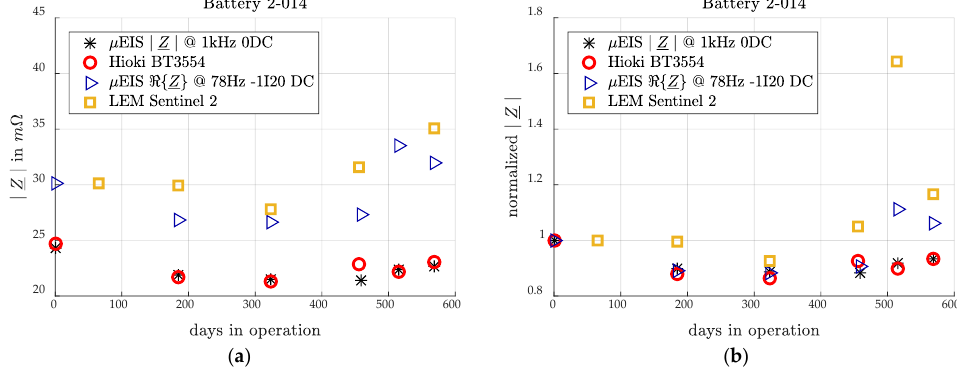
Figure 4. ( a ) Absolute impedance and ( b ) relative impedance values of the two measurement devices LEM Sentinel 2 ( □ ) and Hioki BT3554 ( ○ ) with the corresponding EIS values at 78 Hz with superimposed current of − 1 I 20 ( ▷ ) and at 1 kHz with no superimposed current (0DC) ( ❊ ).